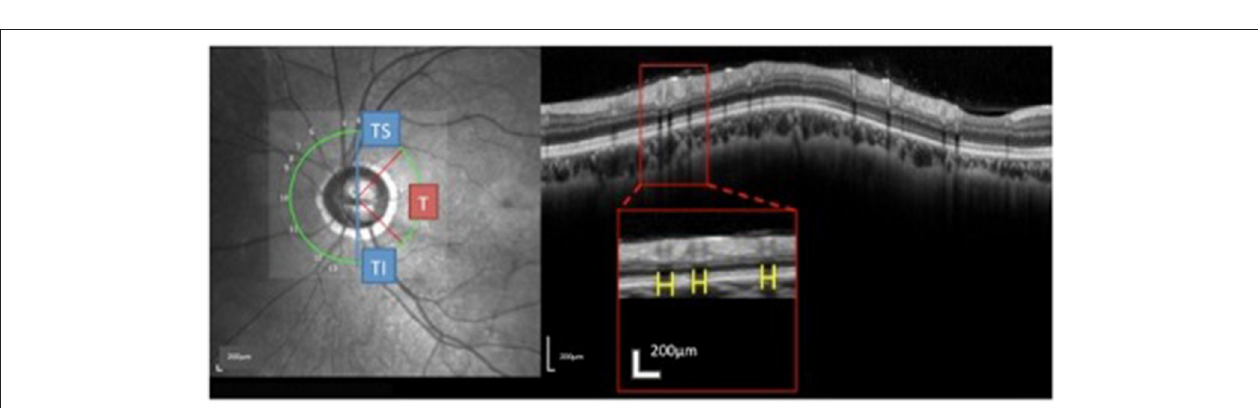
FIGURE 3 | Measurement and regionalized of the retinal vessels (RV) diameter were demonstrated. Using the Spectralis OCT + HRA system, a circular scan with a 3.4mm diameter centered on the optic nerve was performed through natural pupils. Near-infrared reflectance images were obtained simultaneously. The retinal vessel (RV) diameter was measured as the maximum reflectance shadowing width on the retinal pigment epithelium layer. Using Spectralis software (Heidelberg Eye Explorer, version 1.0.10.0), scales (yellow bar) were drawn and measured. The sums of the overall parapapillary RV diameters, and the average parapapillary RNFLTs were determined for the entire region and for the T (315 ◦ -45 ◦ ), TS (45 ◦ -90 ◦ ), and TI sectors (270 ◦ -315 ◦ ) individually.